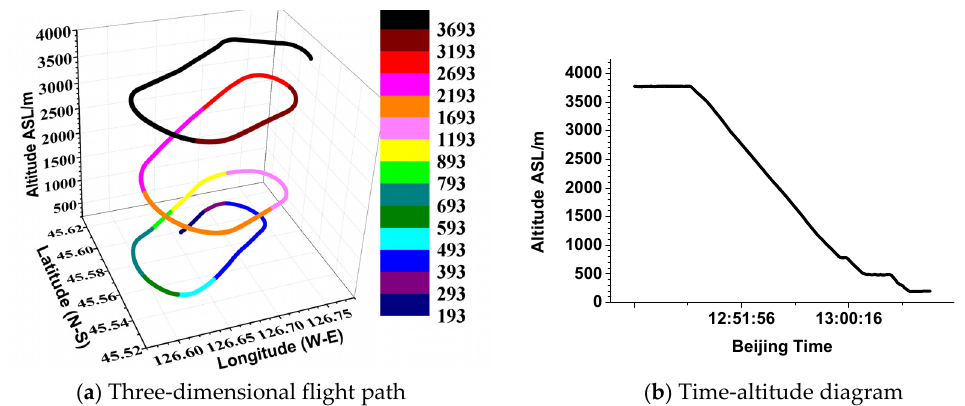
Figure 4. The flight path during the descent phase on 25 October 2016. ( a ) Three ‐ dimensional flight path; ( b ) Time ‐ altitude diagram.